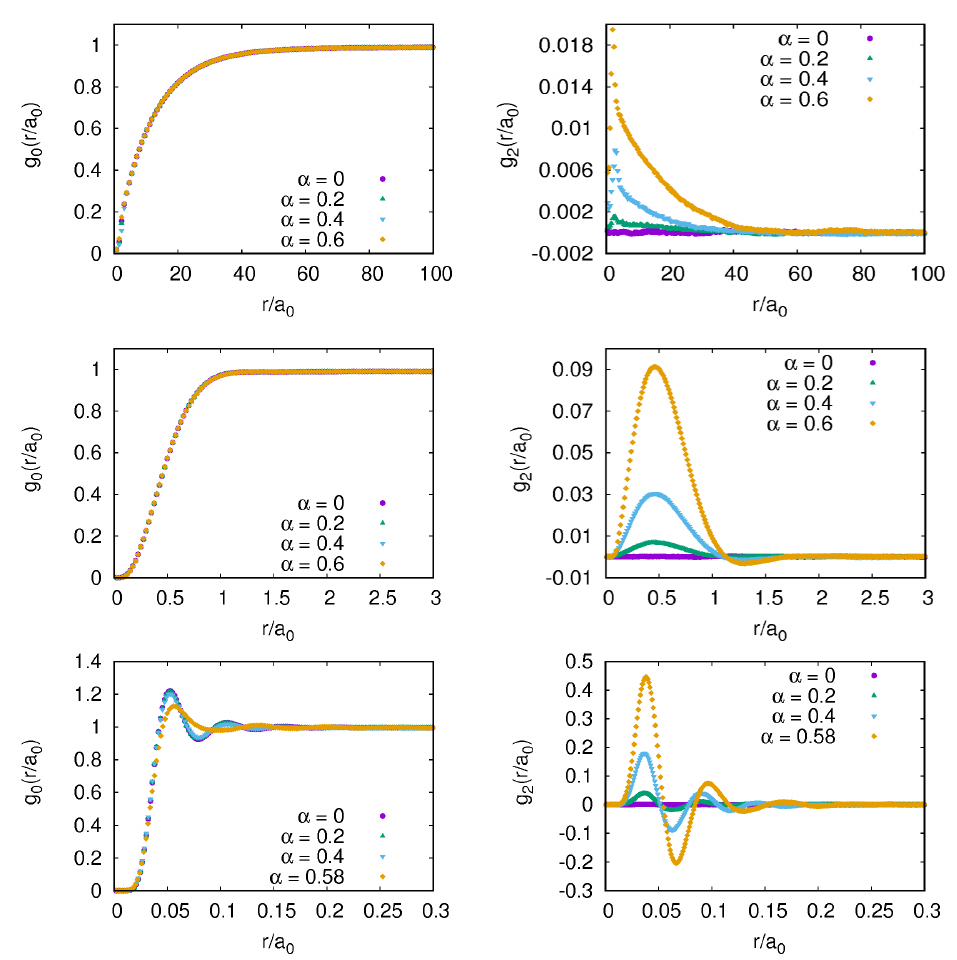
Figure 3: Isotropic (left plots) and first anisotropic modes (right plots) of the pair distribution function for x = 0.001 (top), x = 1 (middle) and x = 350 (bottom) and for different values of the tilting